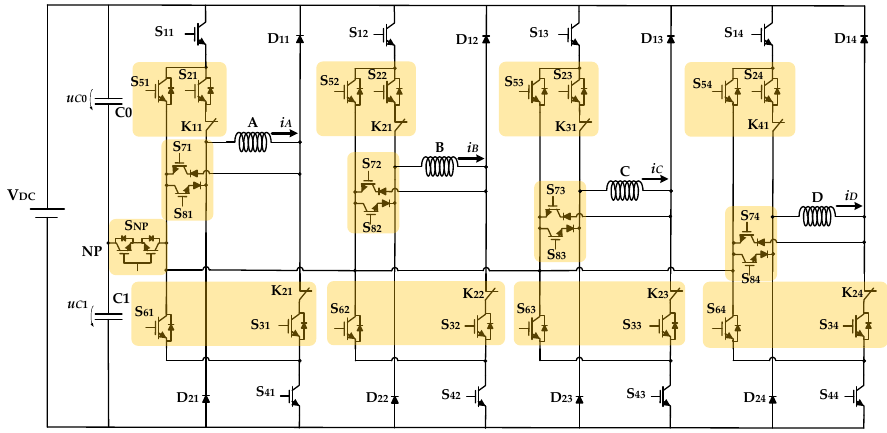
Figure 2. Fault-tolerant solution based on the NPC-AHB topology applied to an 8/6 SRM.